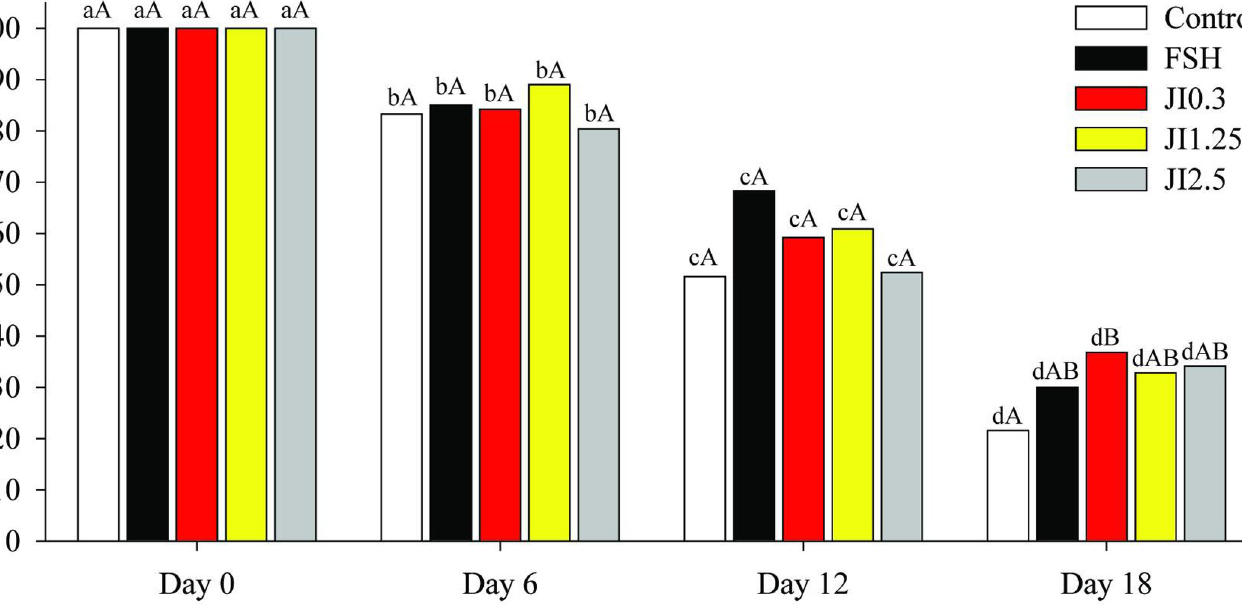
PLOS ONE | https://doi.org/10.1371/journal.pone.0208760 December7,